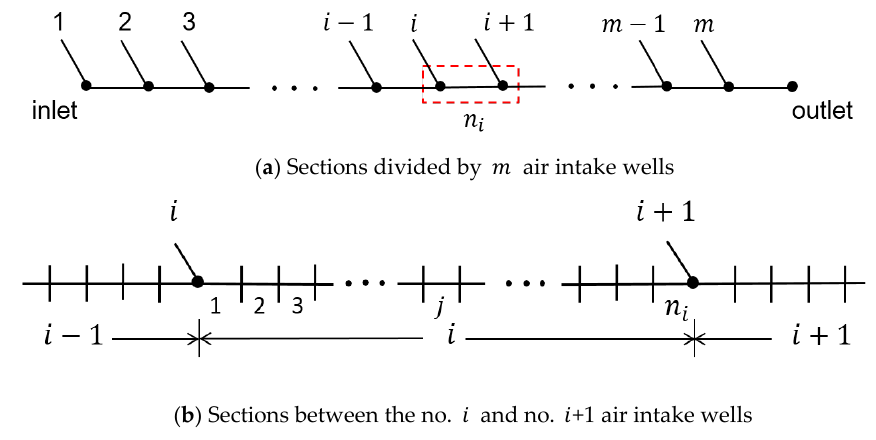
Figure 4. Schematic diagram of the multi-intake-well air supply system.